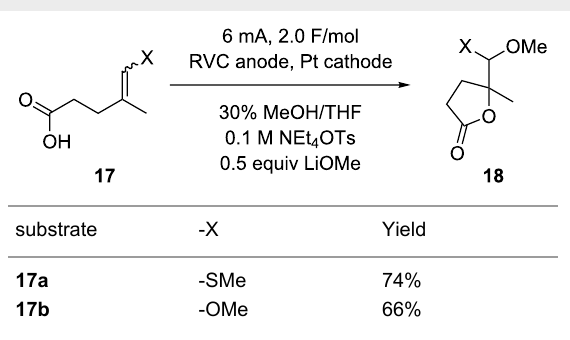
Table 2: Extension to other electron-rich